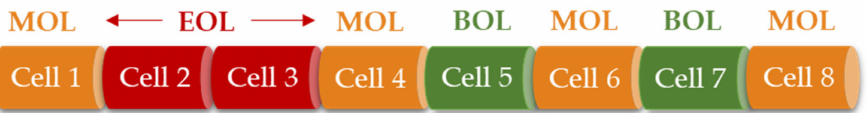
Figure 11. Mixed aging scenario for cell-to-cell variations considered for the 8S module in this study [14].